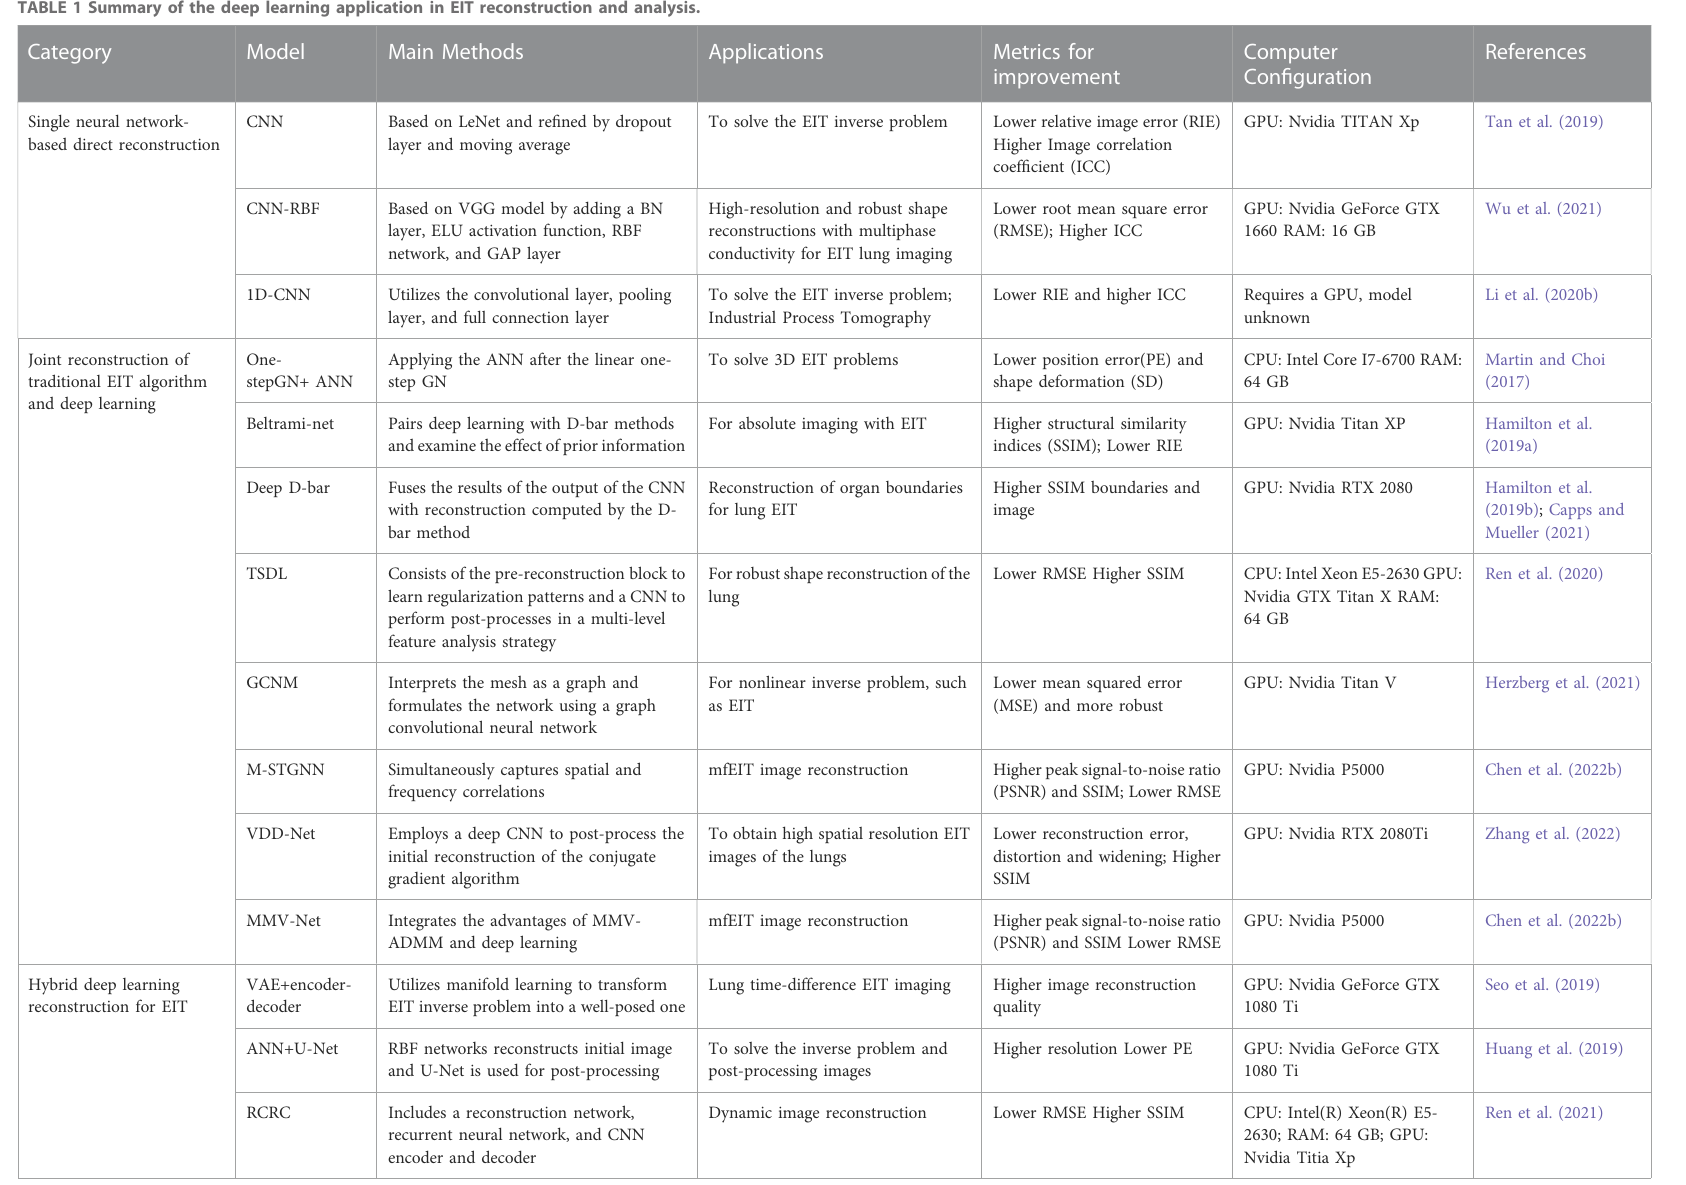
TABLE 1 Summary of the deep learning application in EIT reconstruction and